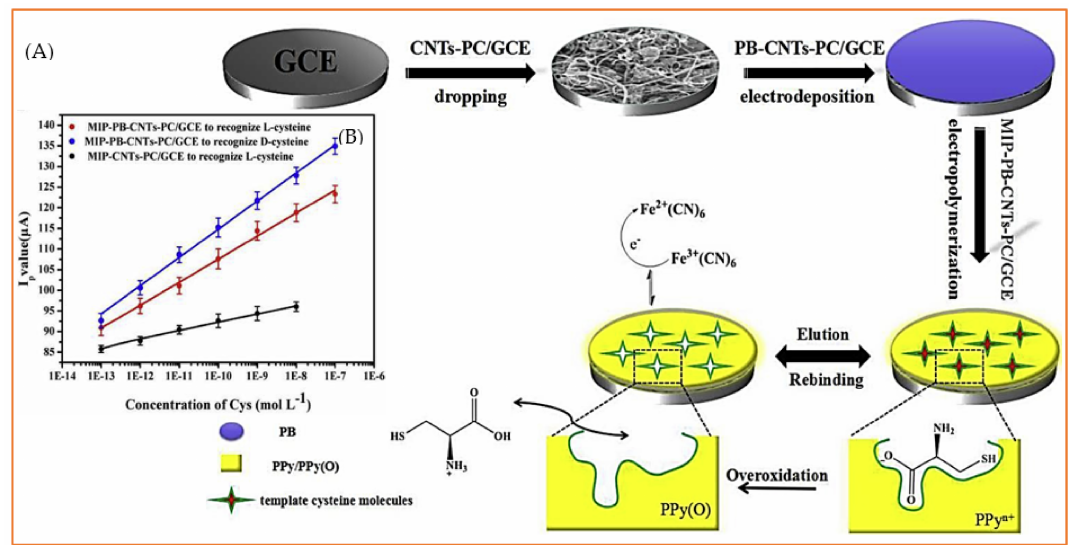
Figure 6. ( A ) The preparation process for a MIP-PB-PC-CNTs/GCE sensor. ( B ) The relationship of the peak values of MIP-PB-CNTs-PC/GCE and MIP-CNTs-PC/GCE with the concentration of L -cysteine and D -cysteine. Reprinted with permission from ref. [112]. Copyright 2019 Elsevier.